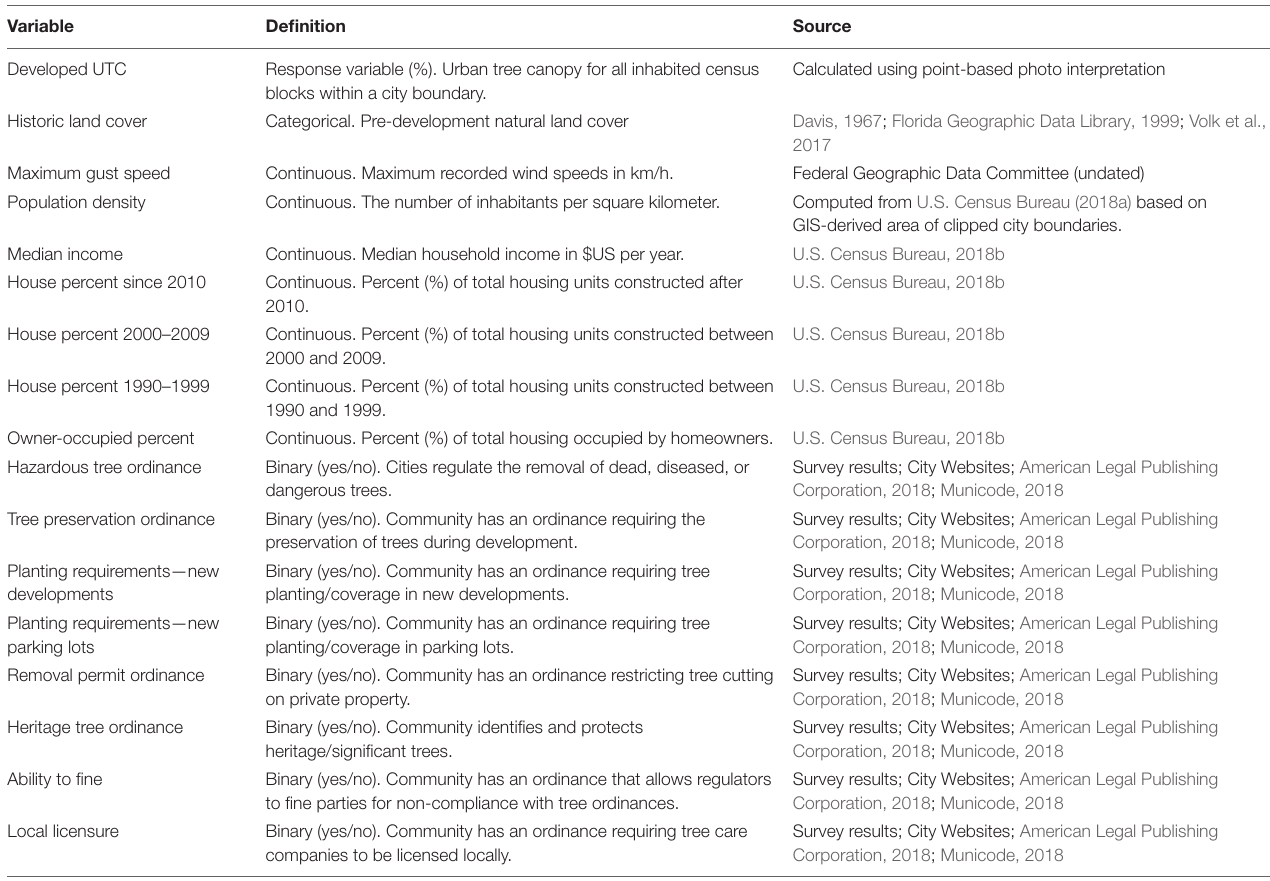
TABLE 1 | Initial model variables tested in predicting urban tree canopy (UTC)